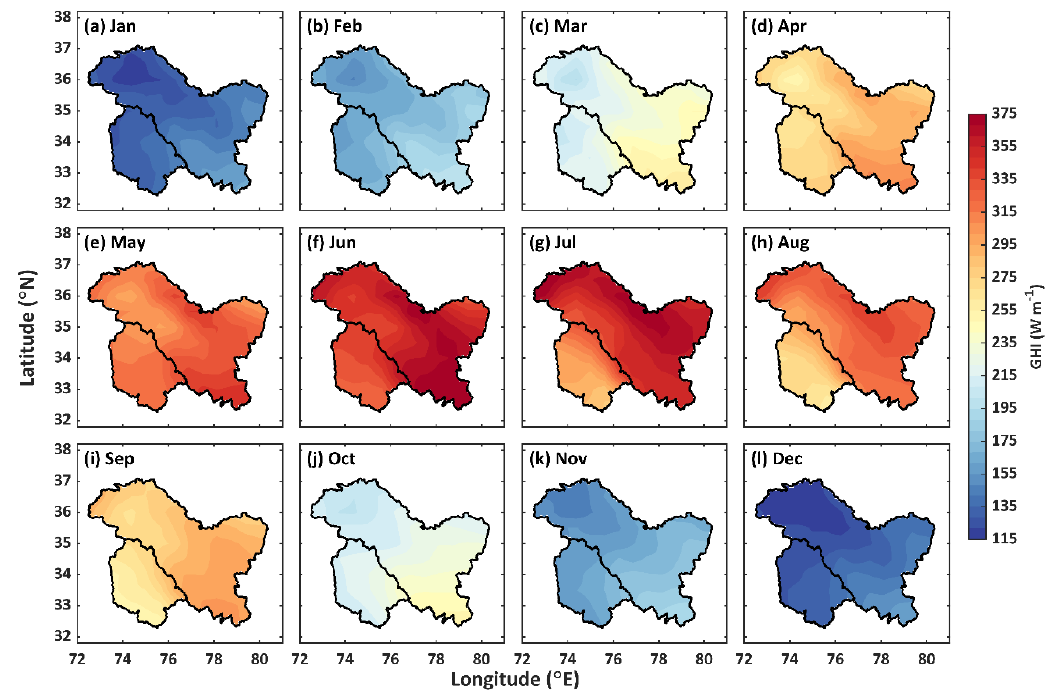
Figure 6 . Spatial distribution of monthly averaged GHI from 1981 to